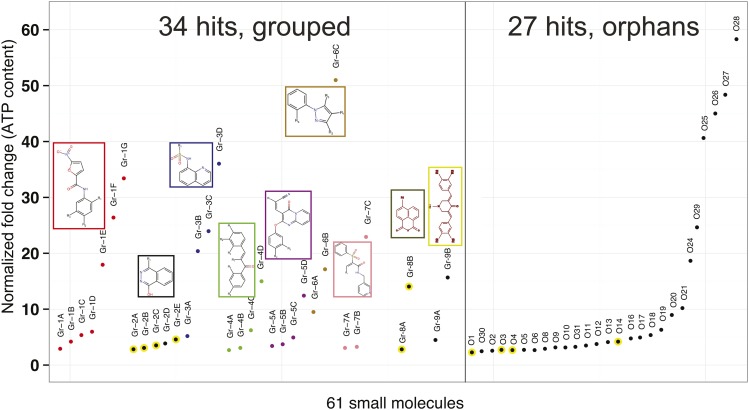
Summary of the top 61 hits that promote H2O2-resistance. Shown are normalized fold changes (ATP content) of H2O2-treated WI-38 cells, which were pre-incubated with each of the top 61 hit compounds that passed the initial selection criteria (see Figure 1). 34 molecules fell into one of nine groups (Gr-1 to 9, shown in different colors – core structures are shown) (see Supplemental Table 1 for structures). Each group comprised two or more members that share a similar core structure. In addition, we identified 27 orphan compounds. Yellow circles: PARP inhibitors (see Supplemental Figure 8).